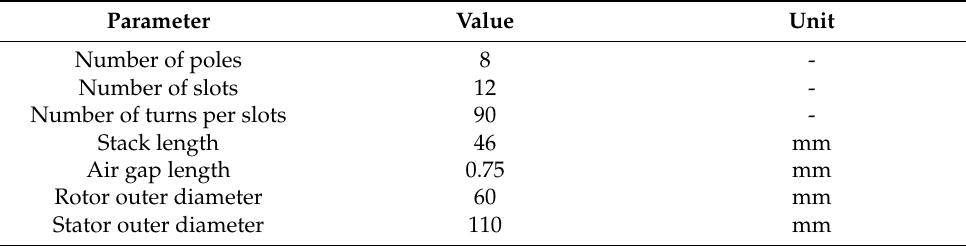
Table 2. Motor parameters of spoke-type and I spoke-type PMSM.